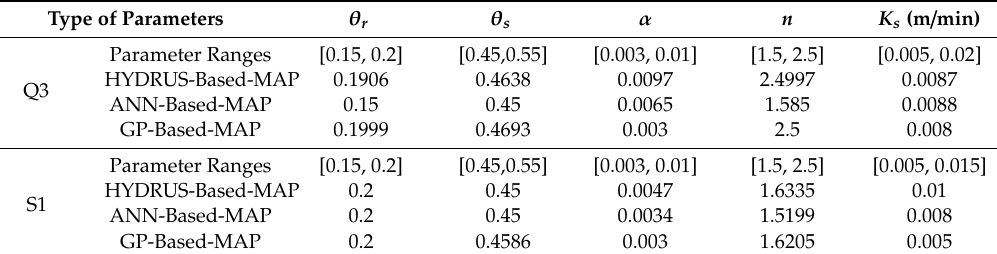
Table 2. Parameter ranges and MAP inversed by three different methods.